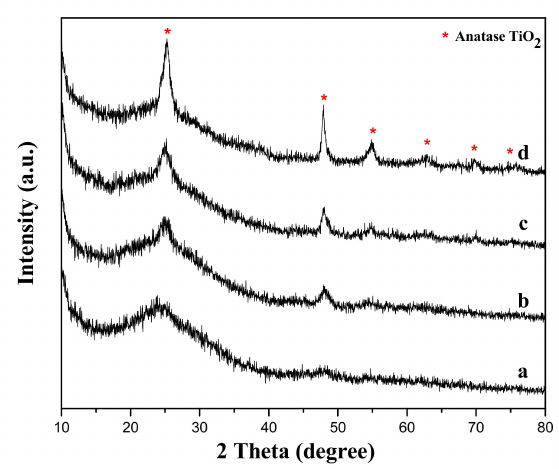
Figure 1. XRD patterns of the samples with different reaction time: ( a ) 0.5 h; ( b ) 2 h; ( c ) 6 h; ( d ) 10